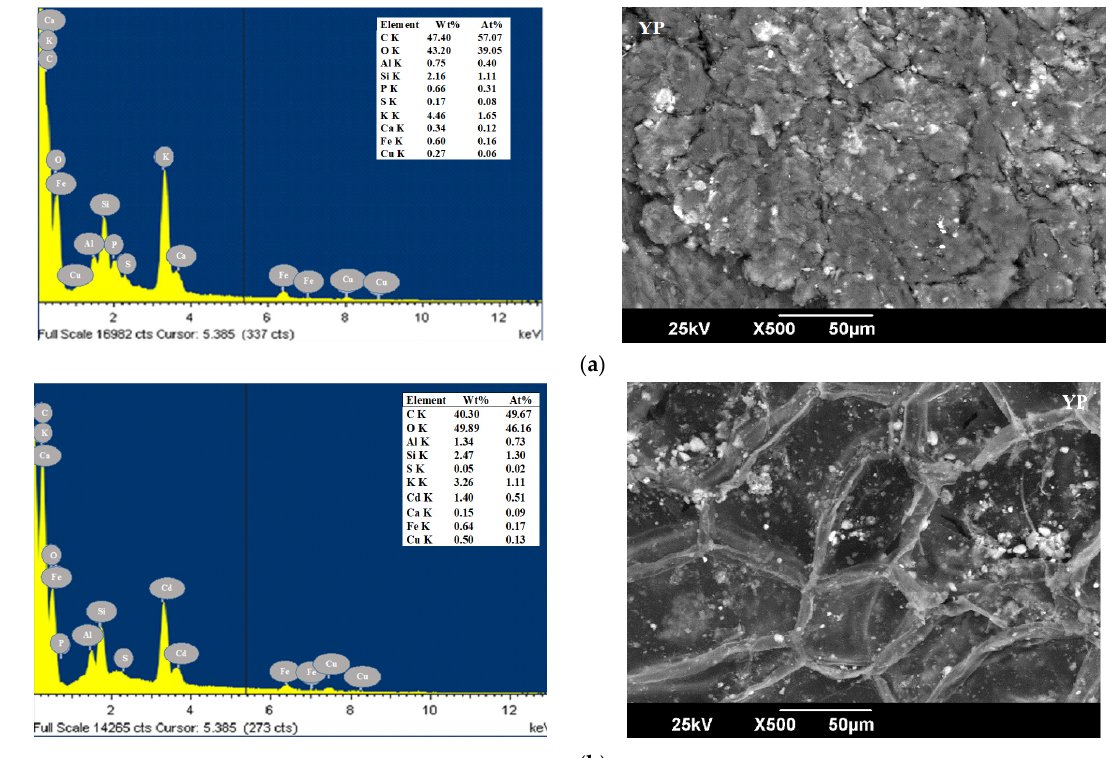
Figure 1. EDS spectra and -SEM micrographies for YP: ( a ) before and ( b ) after adsorption.